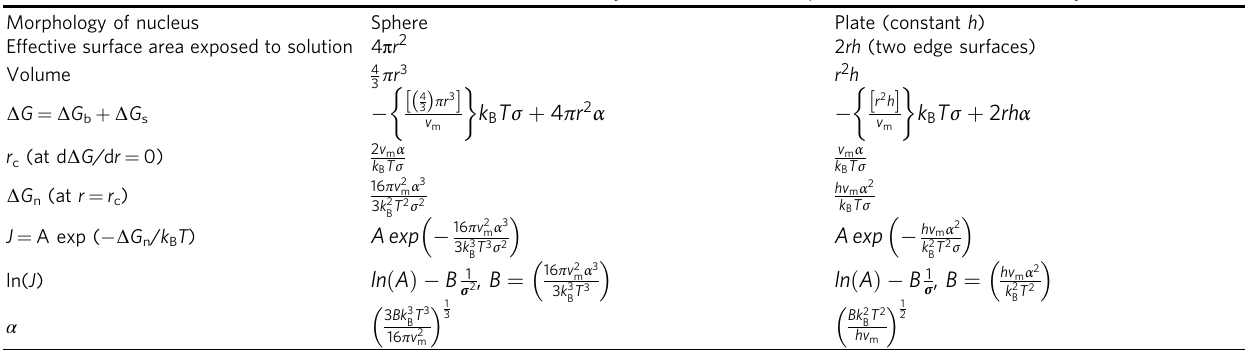
The effect of con fi nement on the shape and growth of nuclei for the con fi ned nucleation model is illustrated in Fig. 1. The morphology of the nucleus changes the parameters in the bulk and surface energy terms ( Δ G b and Δ G s , respectively). As a result, ln( J ) shows a linear relationship with 1/ σ 2 for uncon fi ned nucleation, but with 1/ σ for fully con fi ned nucleation r and h aretheradius(orlengthforthecon fi nednucleationmodel)andheightofnuclei.Forthevolumepermoleculeofnucleus, v m ,5×10 − 23 cm 3 and2.63×10 − 22 cm 3 areusedforACP 25 andforHA 66 , respectively. k B is the Boltzmann constant (1.38×10 − 23 J K -1 ). T is the temperature of the reactor (310K). σ is the supersaturation (ln(IAP/ K sp )), where IAP is the ion activity product and K sp is the solubility product. α is the interfacial energy between nuclei and